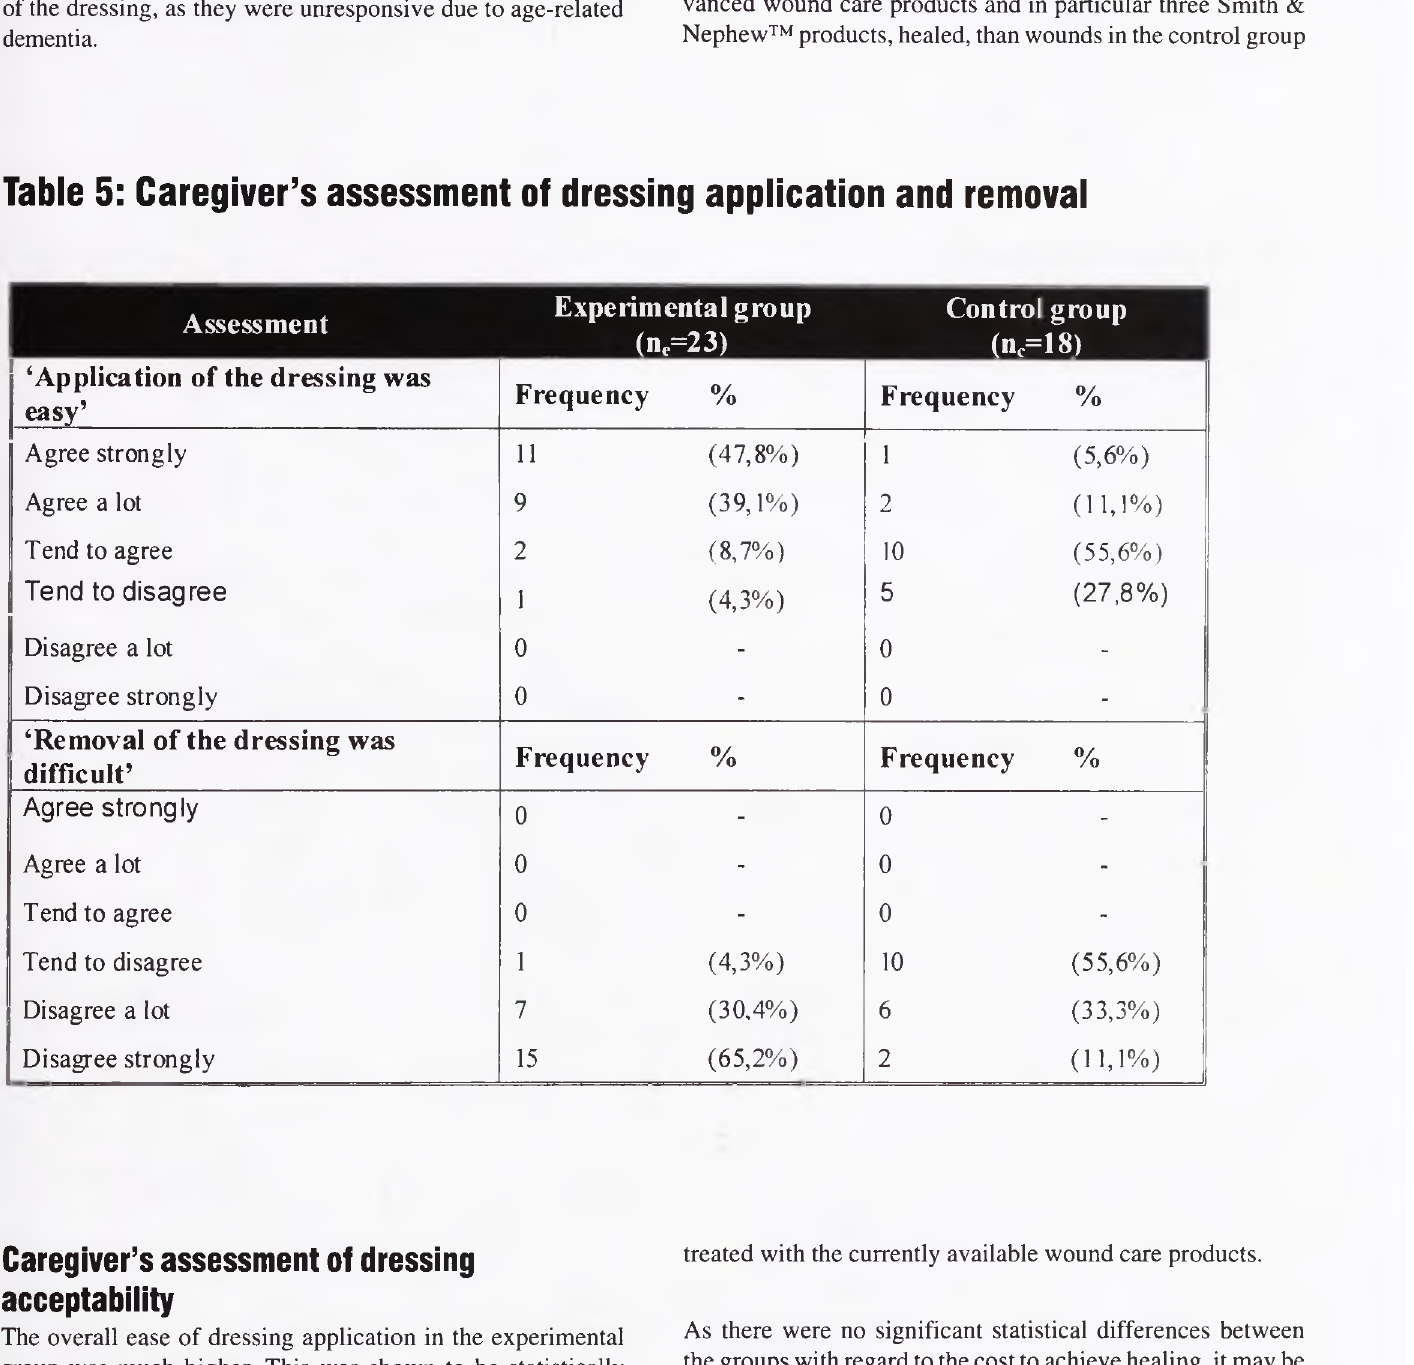
Table 5: Caregiver’s assessment of dressing application and removal